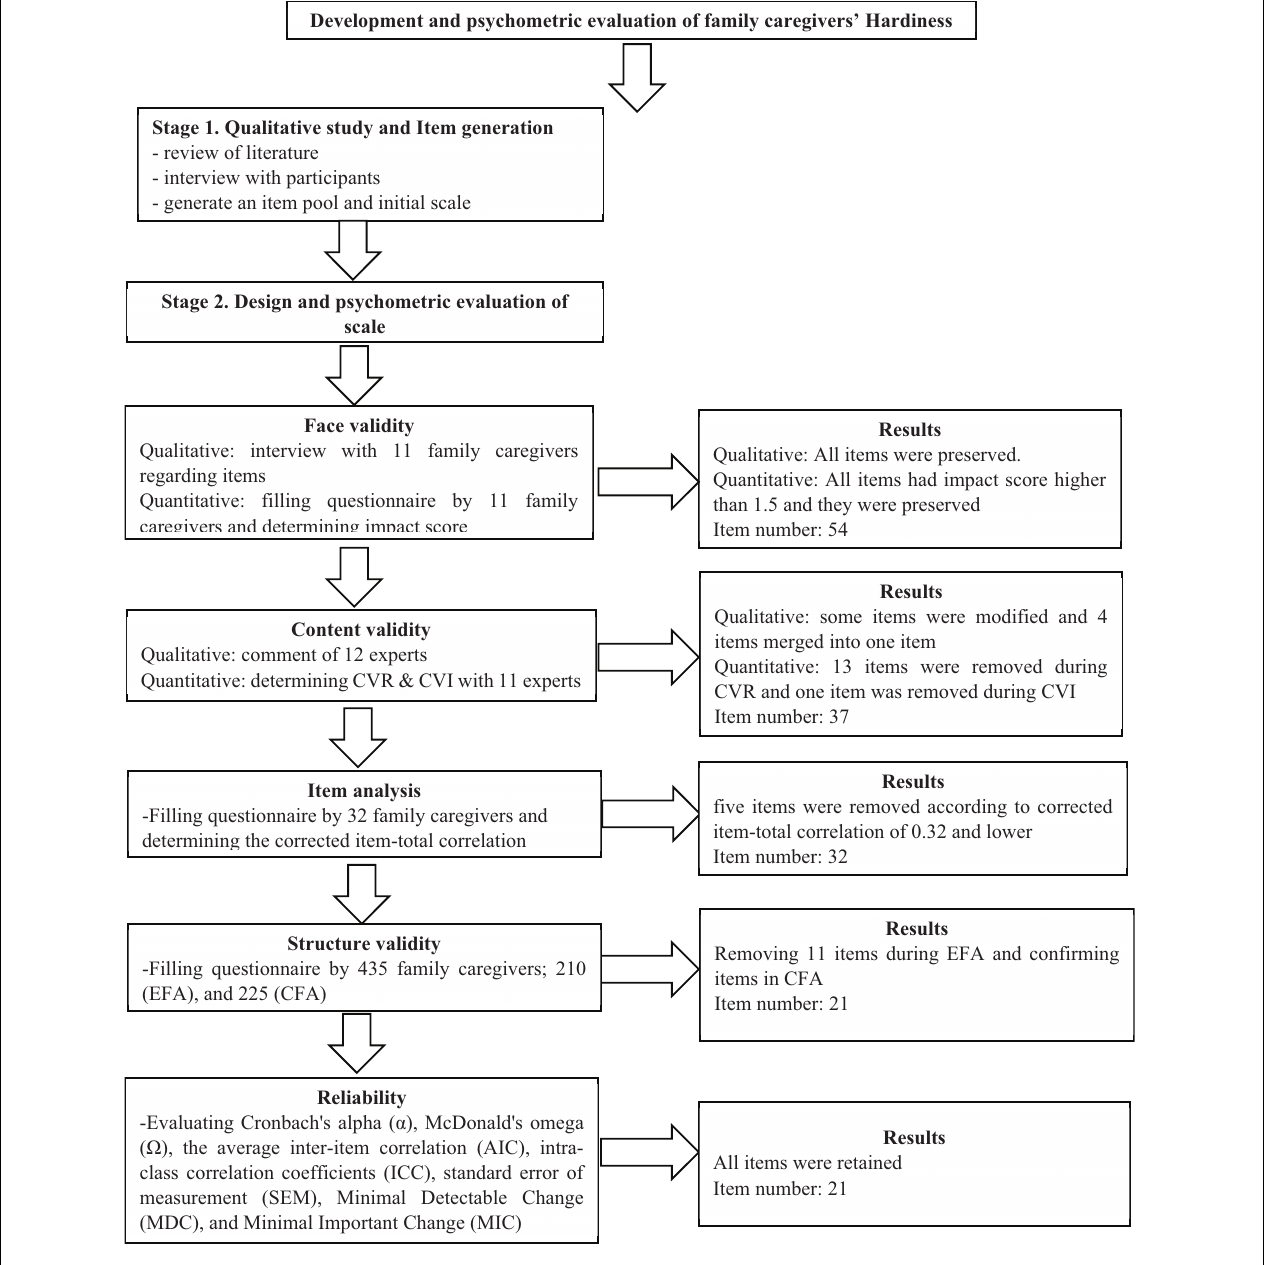
FIGURE 1 | Production phases of family caregiver hardiness scale.